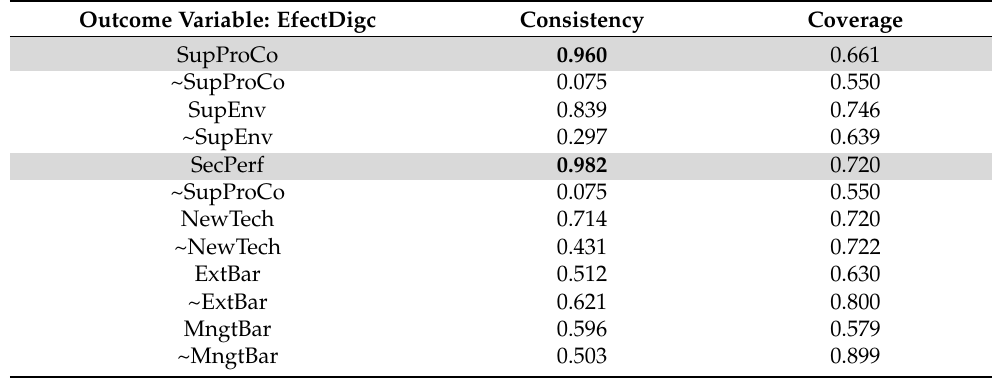
Table 5. Analysis of necessary